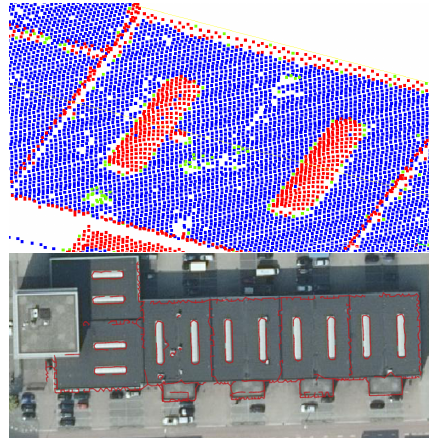
Figure 7. The identified border points (in green on the top image) of the deviation regions (in red) do not always include all critical corner points. Also, shapes with a width of only a few points (such as roof edges) result in border points positioned in a way that leads to the minimum spanning tree confusing opposed edges (bottom image). Please note: connecting the start and end of the minimum spanning tree was not performed within the feasibility study. 1